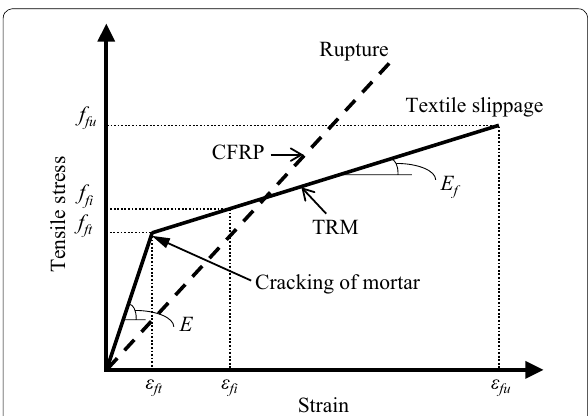
Fig. 10 Idealized stress–strain curve of TRM test specimen according to ACI 549.4R‑13